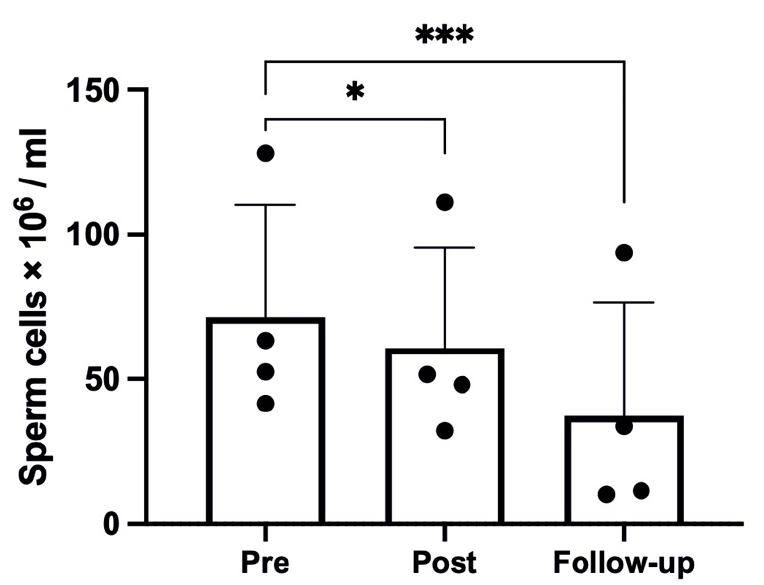
Figure 1. Sperm count results; one participant was removed from the analysis due to too low values; changes over time were significant at * p < 0.05; *** p < 0.001.